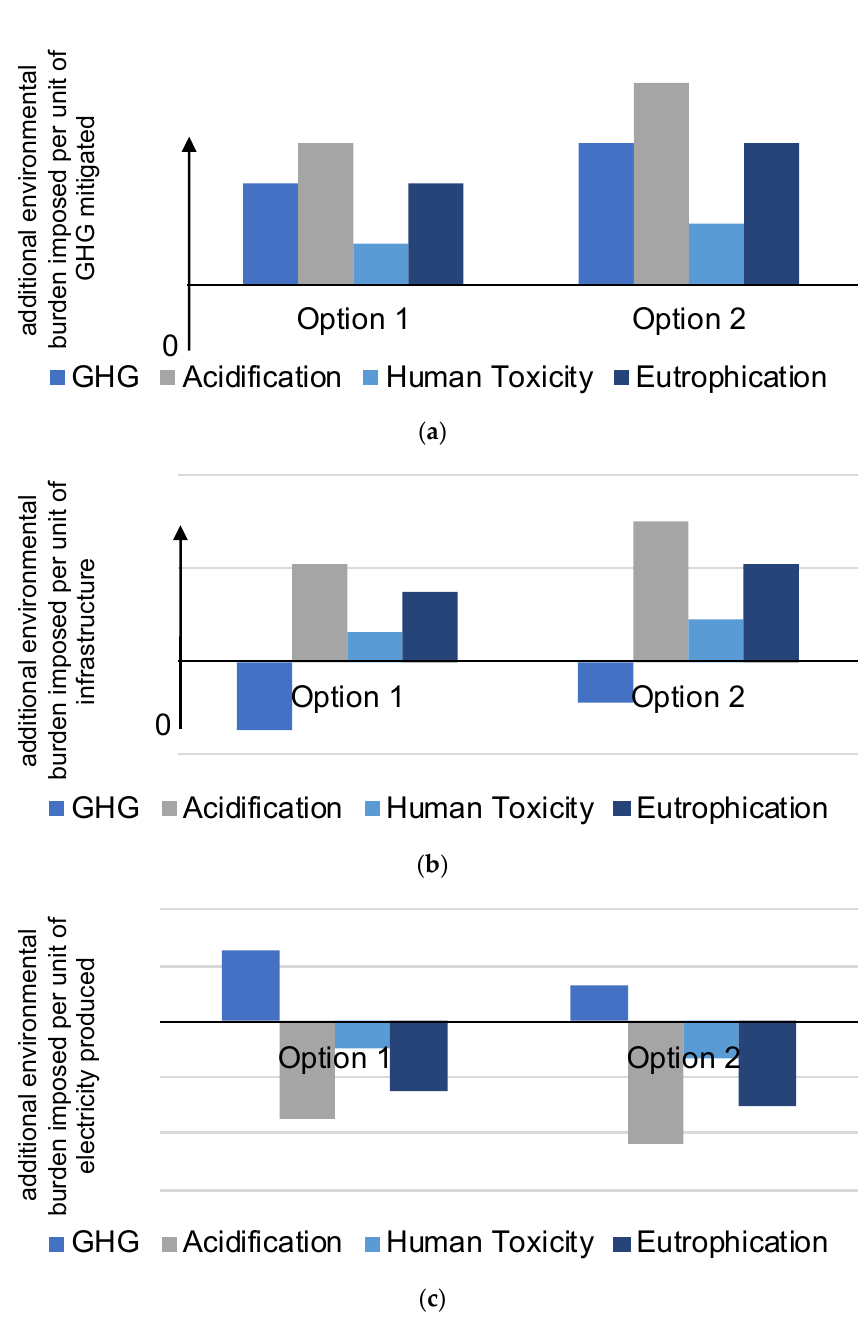
Figure 2. Mitigation LCA interpretability varies by functional unit approach: ( a ) Performance-based functional unit; ( b ) capacity-based functional unit; ( c ) production-based functional unit. Figure 2 illustrates hypothetical GHG, acidification, human toxicity, and eutrophication burden of CCS mitigation infrastructure using functional unit types described in Table 1. Visualizing the impact on a performance basis (here, tonnes of CO 2 sequestered by a hypothetical power sector carbon sequestration infrastructure) (Panel A) leads more easily to the interpretation that Option 1 is a more environmentally efficient negative carbon technology than Option 2 versus Panel B’s visualization on a capacity basis. As Panel C shows, trying to evaluate this retrofitted CCS unit using a production-based functional unit in the form of a typical power plant’s functional unit (kilowatt hour, kWh) results in nonsensical results because the delivered kWh are negative.